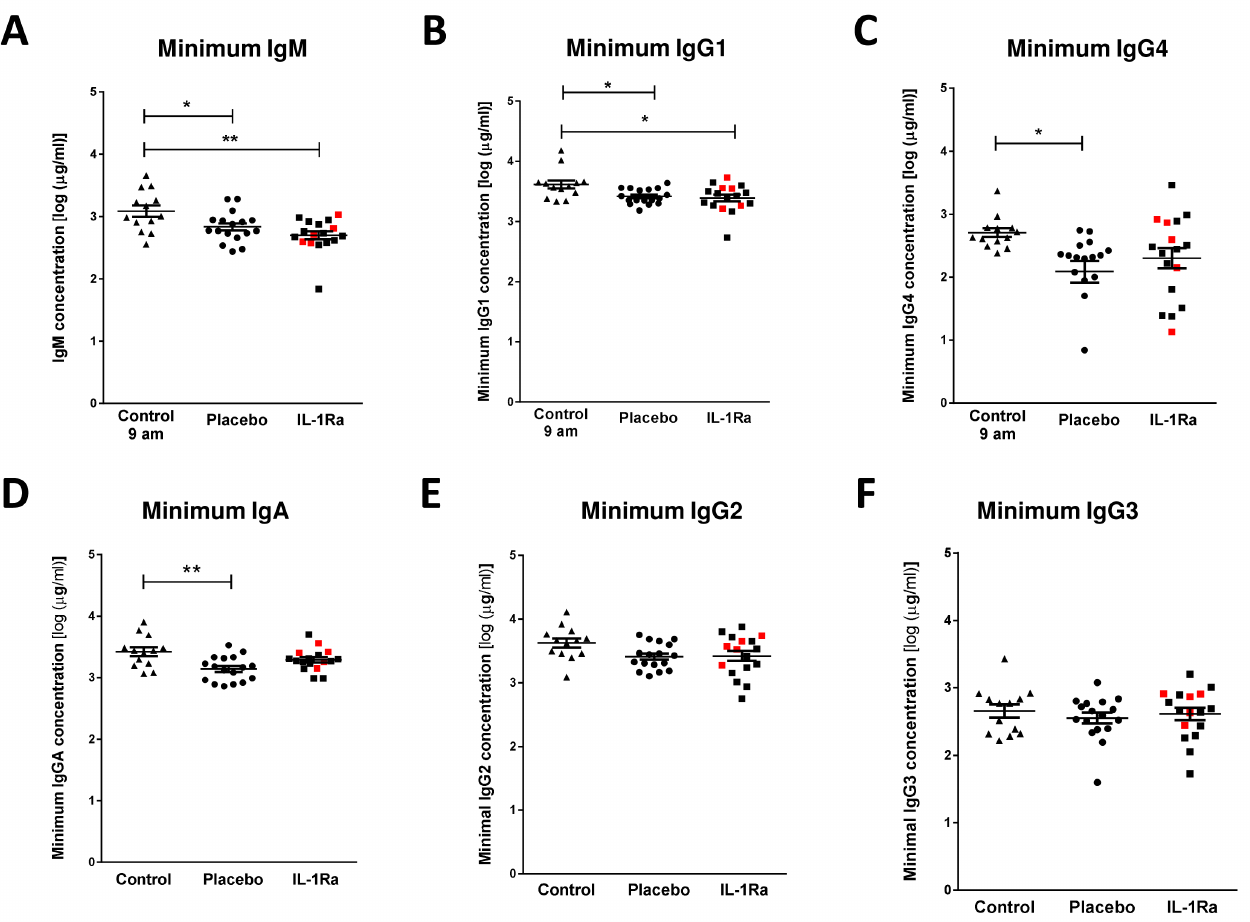
Figure 1. Reduced plasma IgM, IgA, IgG1 and IgG4 after stroke is not affected by IL-1 receptor antagonist (IL-1Ra). ( A ) Minimum IgM concentration measured in the first seven days after stroke was lower in both placebo and IL-1Ra treated patients in comparison to healthy controls. Data show mean ±SD, * P<0.05 , ** P<0.0 1 , one-way ANOVA with Bonferonni correction. ( B ) Minimum concentration of IgG1 and measured in the first seven days after stroke was reduced in both placebo and IL-1Ra treated patients in comparison to healthy controls. Minimum IgG4 ( C ) and IgA ( D ) concentrations were reduced in placebo-treated stroke patients in comparison to healthy controls. There was no significant difference between placebo-treated and IL-1Ra-treated stroke patients. No significant difference in IgG2 ( E ) and IgG3 ( F ) concentration was detected between placebo-treated and IL-1Ra-treated stroke patients in comparison to healthy controls. Data show mean ±SD, * P<0.05 ; ** P<0.01 ; one-way ANOVA with Bonferonni